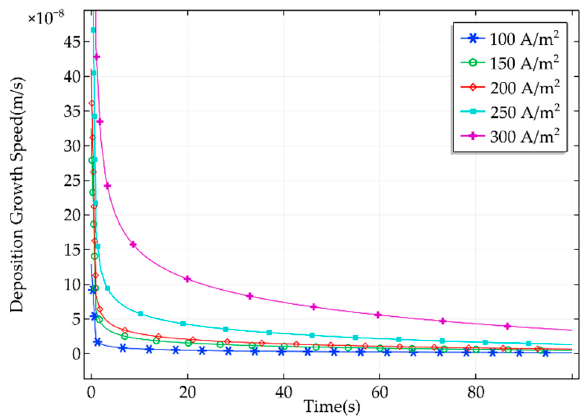
Figure 5. Deposition growth speed corresponding to different current densities.